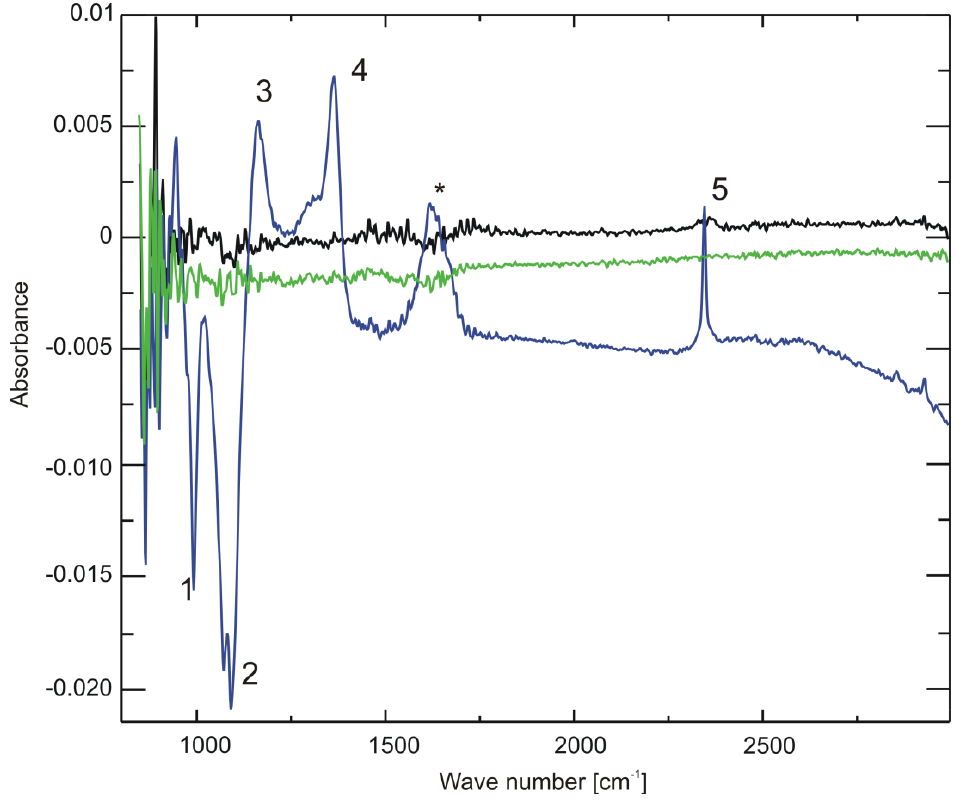
Figure 7. Attenuated Total Reflection Fourier-Transform Infrared Spectroscopy (ATR-FTIR) spectra of three buffer samples frozen overnight at −20 °C (black), −80 °C (green) or on dry ice (blue). A spectrum of buffer stored overnight at 4 °C was used as a reference and was subtracted from all other